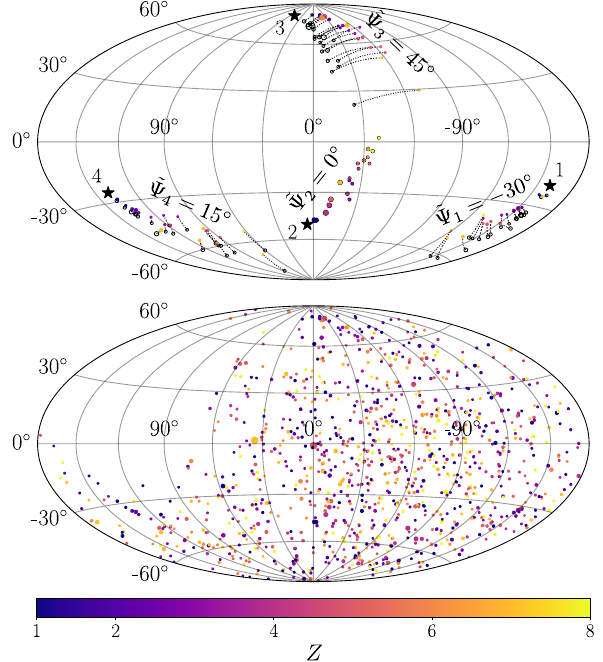
Fig. 5 Constructionofbenchmark1scenarioconsistingoffourdistinct sources, in the Galactic coordinate system. Each of the four sources (black star symbols) contributes N s = 20 source events with color coded charge number Z . (Top) Construction of implementing GMF uncertainties for the source events. (Bottom) Complete simulations of 80 source events and 1039 isotropically distributed arrival